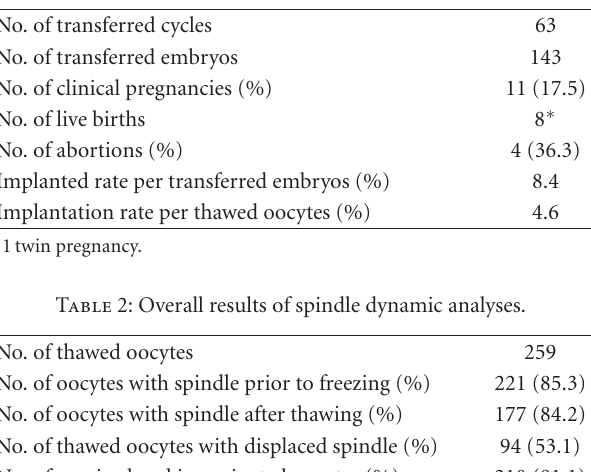
Table 1: Overall clinical results of frozen oocyte cycles.